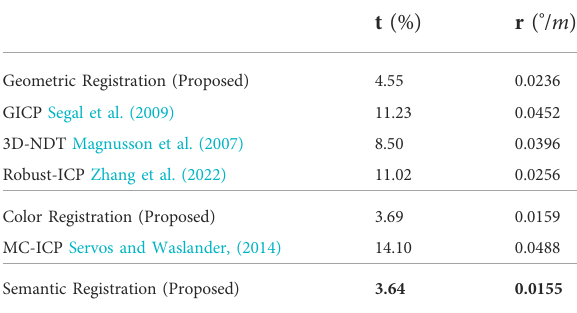
TABLE 1 Results of the proposed frame-to-frame method using the KITTI (Geiger et al., 2012) stereo odometry benchmark averaged over Sequence 00 – 10. The table lists the average drift in translation, asa percentage(%),and rotation,in degrees permeter( ° / m ).The drifts are calculated for all possible subsequences of 100, 200 ... ., 800 m.